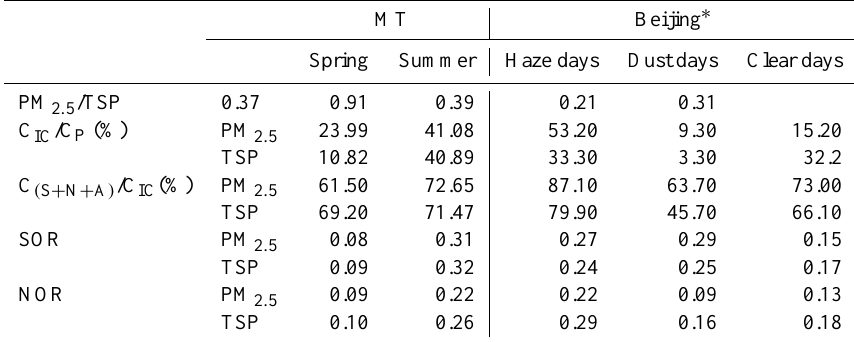
Fig. 2. Daily variations of TSP and PM 2.5 from 14 March to 30 June in 2006 at MT.